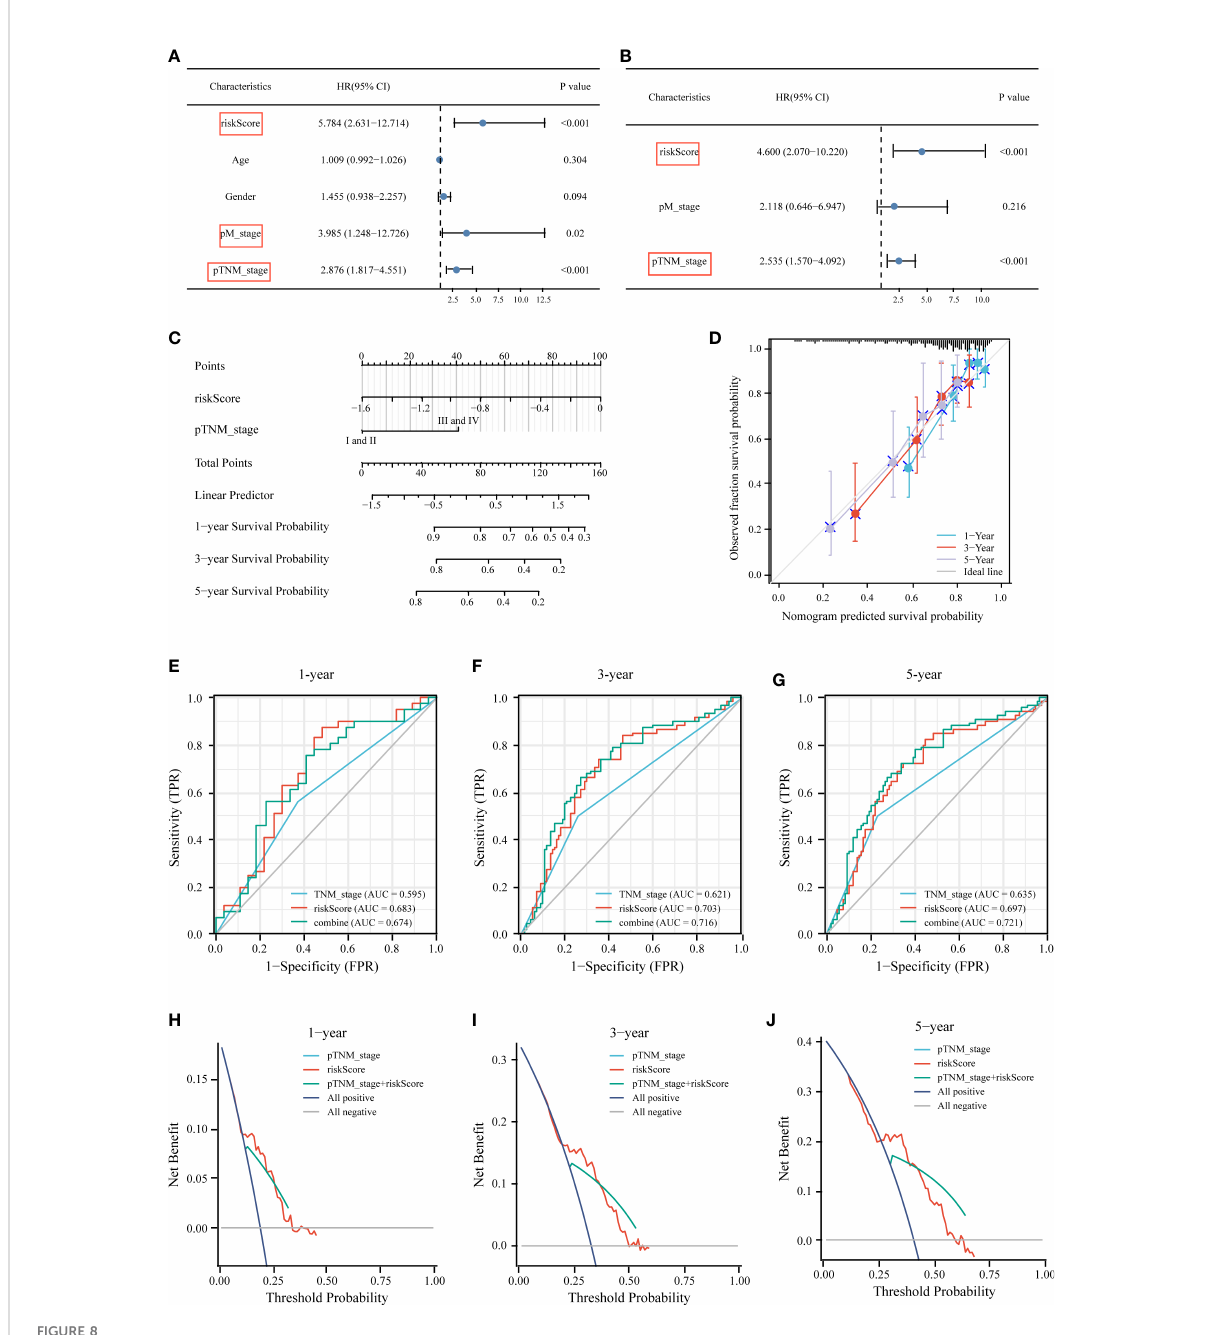
FIGURE 8 Construction of the nomogram for predicting OS of HCC patients in TCGA cohort. Univariate (A) and multivariate (B) forest plots of the risk score model and clinicopathological characteristics associated with overall survival. (C) The nomogram was constructed based on two independent prognostic factors. (D) Calibration plot for internal validation of the nomogram. Time ‐ dependent ROC (E – G) and DCA curves (H – J) of the TNM stage model, risk score model, and the combined model for 1 ‐ , 3 ‐ and 5 ‐ year OS